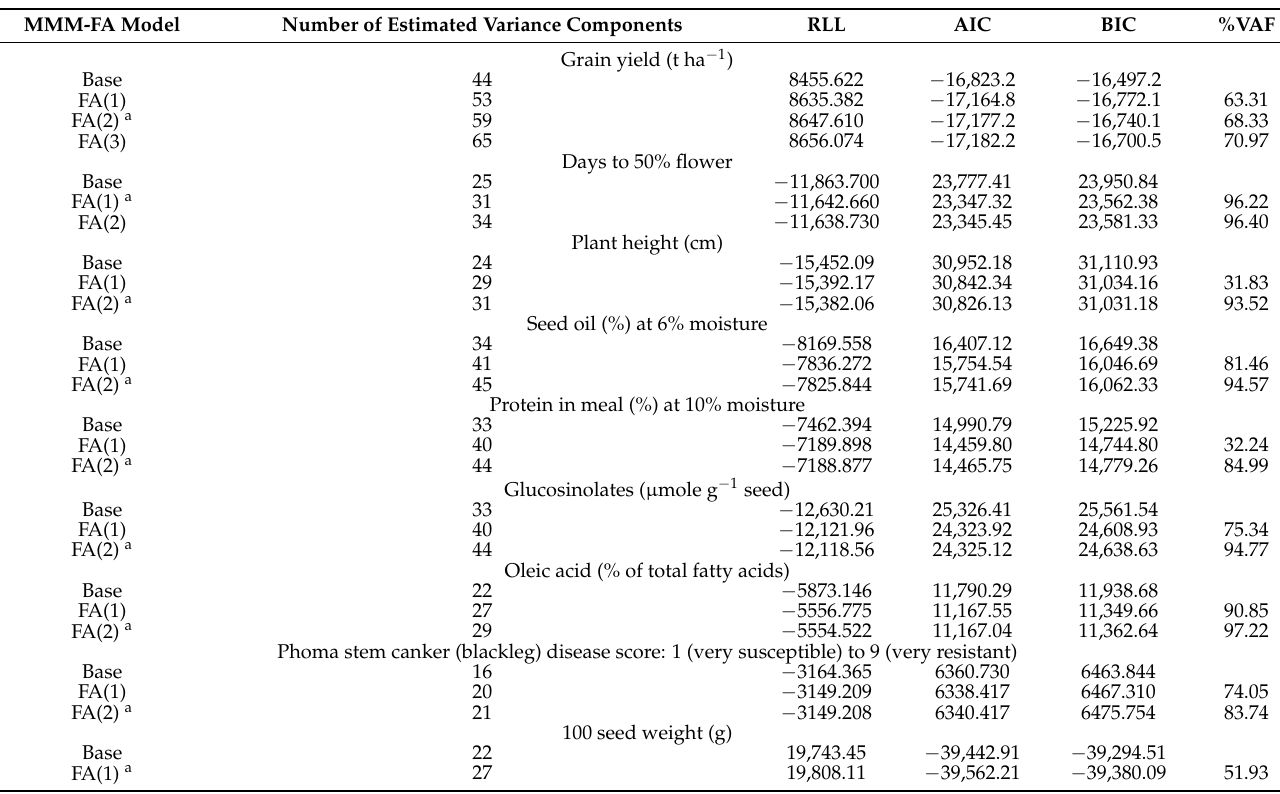
a Optimum MMM-FA model chosen for assessment of overall performance and predicted breeding values of